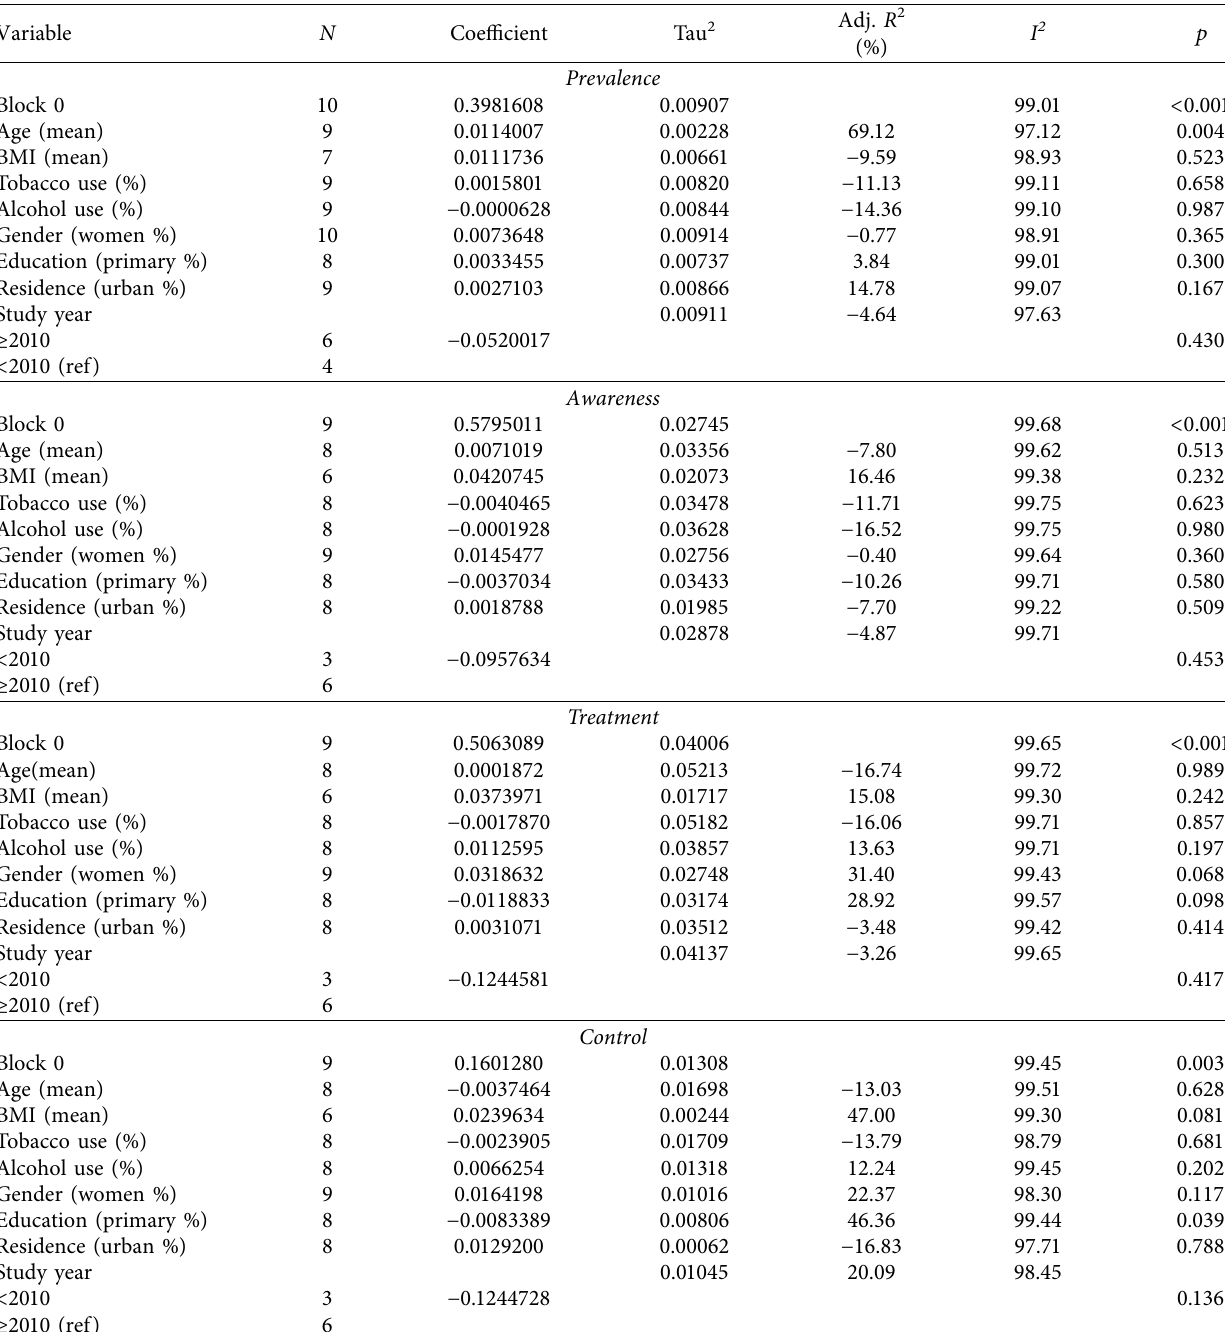
Table 3: Meta-regression analysis of the Mongolian group to explore potential sources of heterogeneity, prevalence, awareness, treatment, and